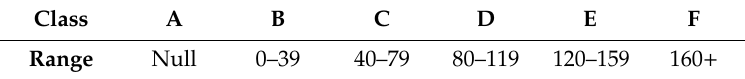
Table 2. Class ranges used across the data set for the purposes of spatial